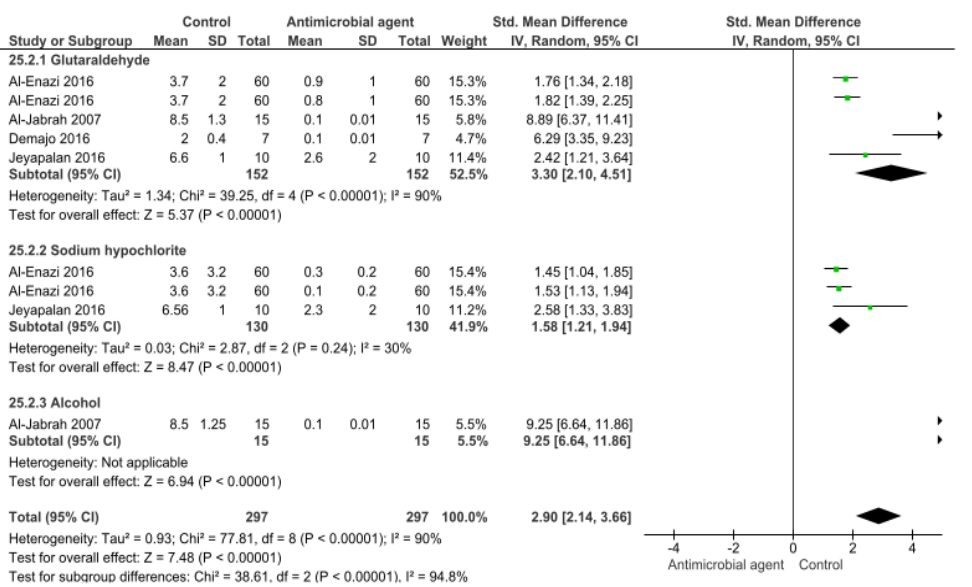
Figure 3. Forest plot of the analysis of CFU/mL count in polyvinyl siloxane after disinfection.